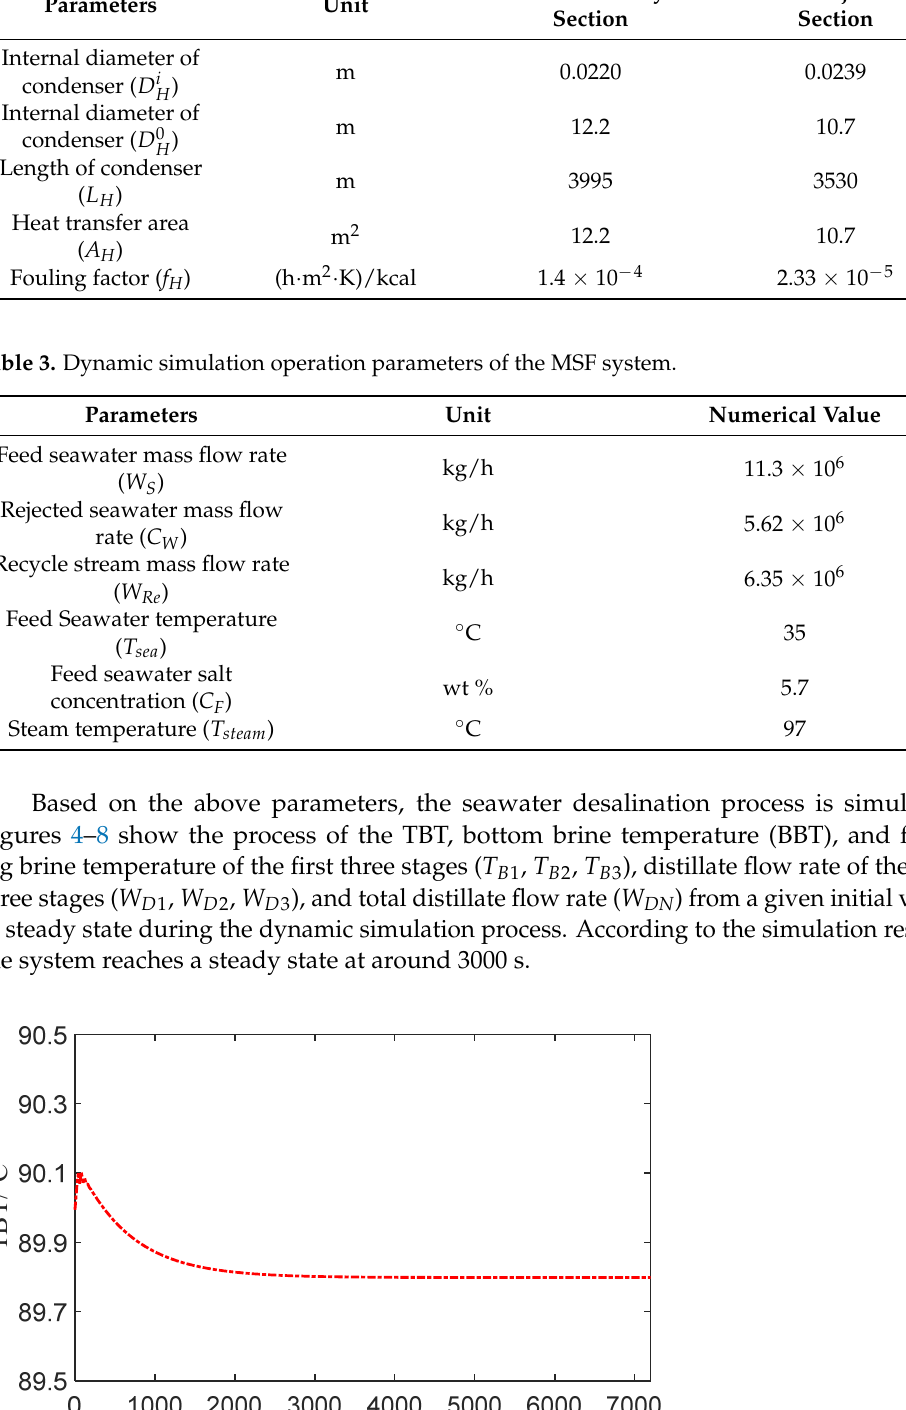
Figure 5. Bottom brine temperature ( BBT) dynamic response with time. Figure 6.